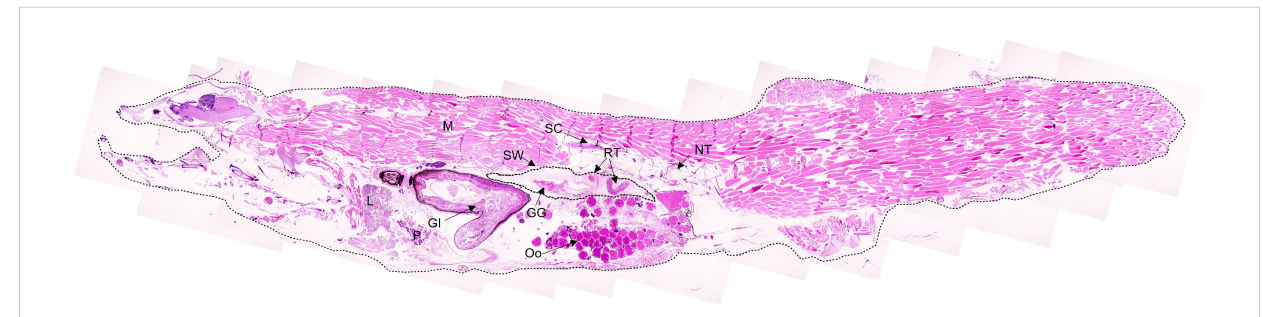
FIGURE 5 Histological image composition of a 20 mm C. braueri showing a longitudinal section of a specimen from head to midtail region. GG stands for Gas Gland, GI for Gastro-Intestinal, L for Liver, M for Muscle, NT for Notochord, P for Pancreas, Oo for Oocytes, RT for rete mirabile , SC for Spinal cord, and SW for